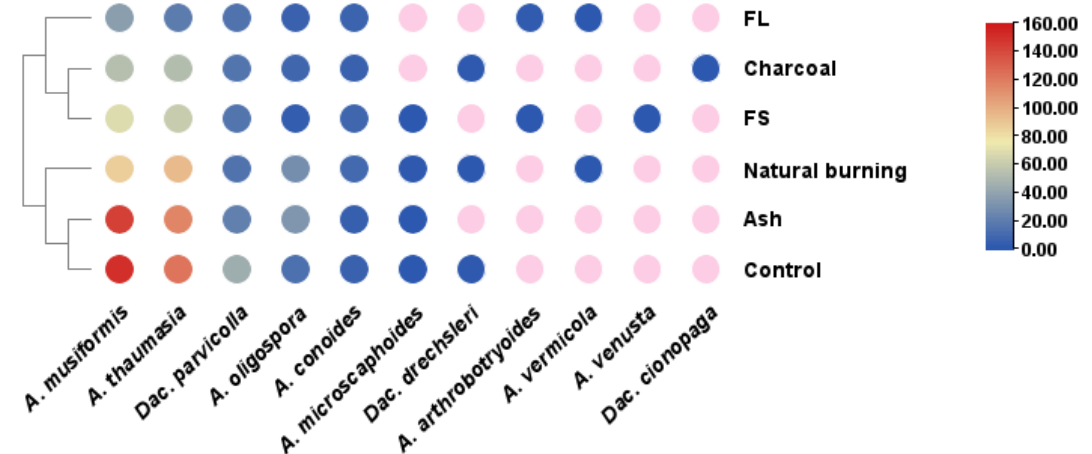
Figure 5. The nematode-trapping fungi (NTF) community composition of each treatment. Pink plots indicate no detection. FS: treated with flame gun and the burn duration was 20 min; FL: treated with flame gun and the burn duration was 60 min; Charcoal: treated with Charcoal; Ash: treated with cooled ash; Natural burning: treated with dry pine needles placed directly on the soil and let burn naturally and ashes were left on the soil after burn; Control: without any treatment.